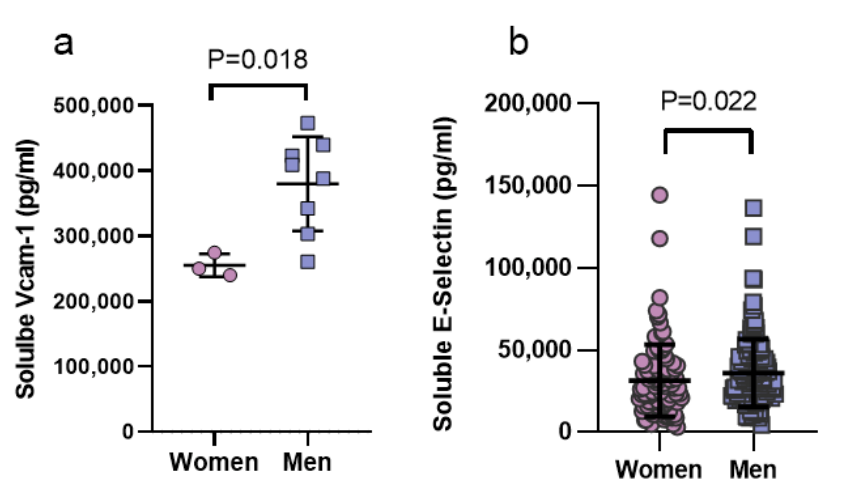
Figure 6. Sex differences in the circulating endothelial injury markers in patients with COVID-19. ( a ) Circulating VCAM-1 protein was significantly elevated in men (n = 7) as compared to women (n = 3) affected by COVID-19. ( b ) Men (n = 136) displayed higher circulating E-Selectin as compared to women (n = 106) in COVID-19. Data were analyzed by Mann-Whitney test between two groups. p < 0.05 was defined to be statistically significant. All data are expressed as mean ± s.d.